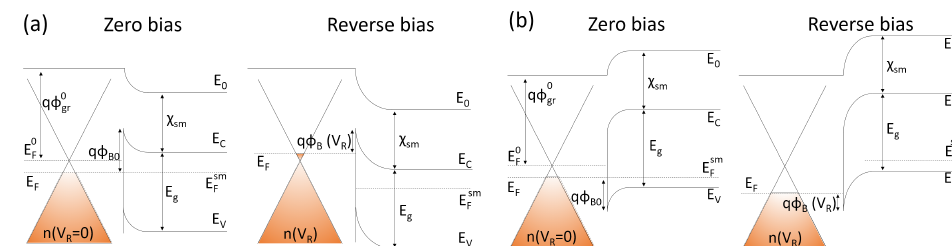
Figure 2. Band diagrams of ( a ) graphene/n-semiconductor and ( b ) graphene/p-semiconductor junc- tions at the thermal equilibrium and when a reverse bias V R is applied. At the thermal equilibrium, graphene has an initial carrier density n ( V R = 0 ) . After a reverse bias this charge density becomes n ( V R ) . E 0 represents the vacuum energy level while E 0 is the Dirac point. Φ 0 gr , χ sm , E g , E C , and E V F are respectively the intrinsic graphene work function, electron affinity, conduction band, bandgap, and valence band. E sm is the Fermi energy level in the semiconductor and q Φ B0 the Schottky barrier F at zero bias. The values of the Schottky barrier q Φ B depend on the graphene Fermi energy level E F that shifts when a voltage is applied.